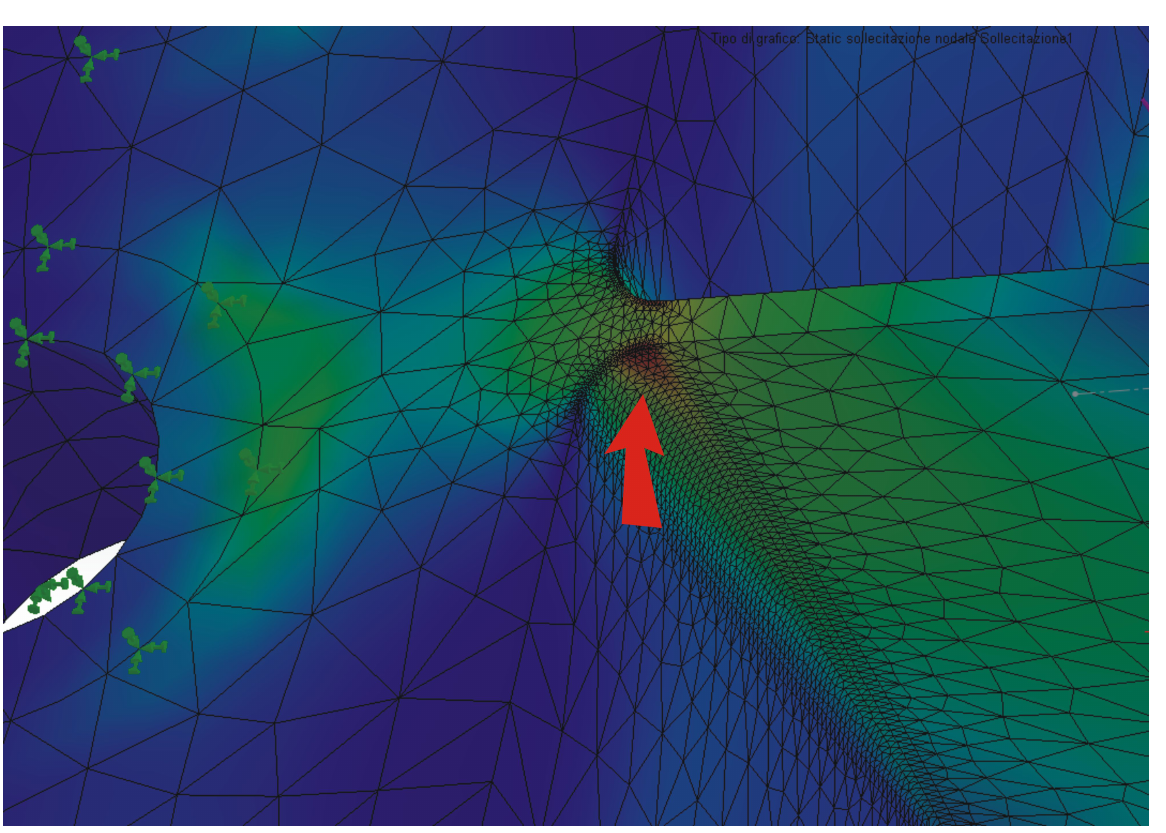
Figure 24: Stresses concentration on the filleted